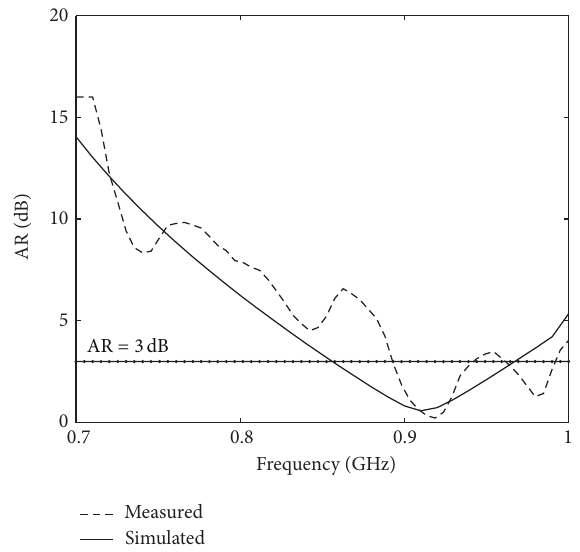
Figure 5: Simulated and measured axial